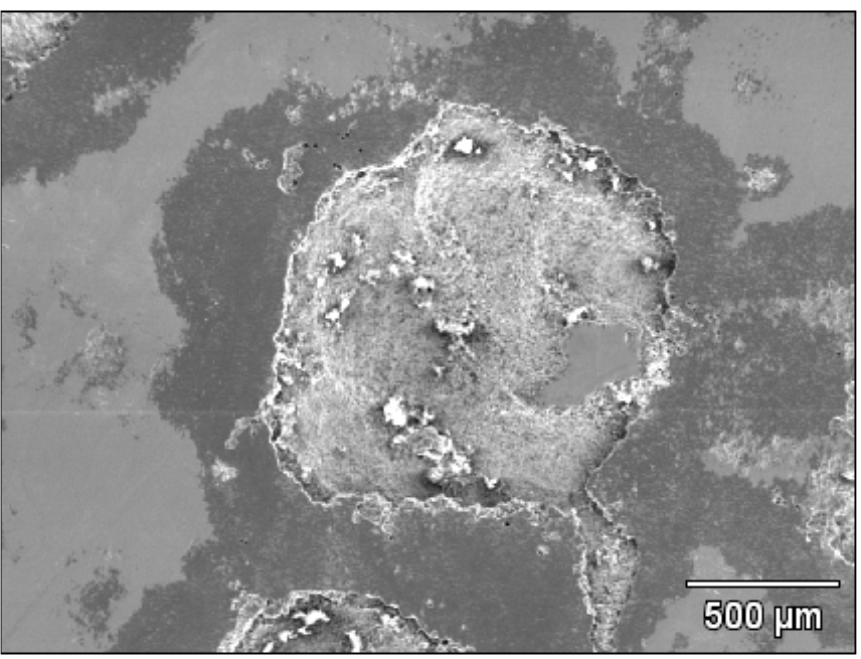
Figure 7. SEM image of localized corrosion defect after immersion test of API-5L-X60 steel under synthetic-produced water.